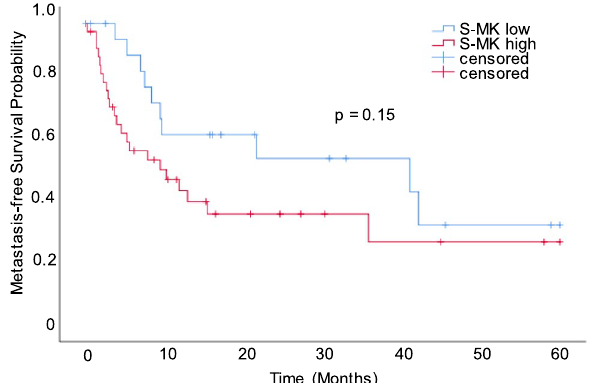
Figure 7. Trend towards later occurrence of metastases in NSCLC patients with low S-MK compared to high S-MK expression. Abbreviations: S-MK serum-midkine, NSCLC non-small lung cancer. Kaplan–Meier metastasis-free survival analysis of NSCLC patients with low (S-MK < 6.71 log pg/ml; n = 22) and high S-MK levels (S-MK ≥ 6.71 log pg/ml; n = 37). Patients were followed up for 5-years post-surgery. Statistical difference was determined using the log-rank test (p = 0.15).